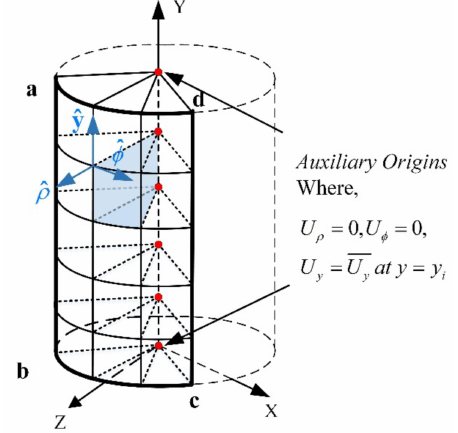
Figure 4. Schematic illustration of the 3D basic unit for kinematic analysis in cylindrical